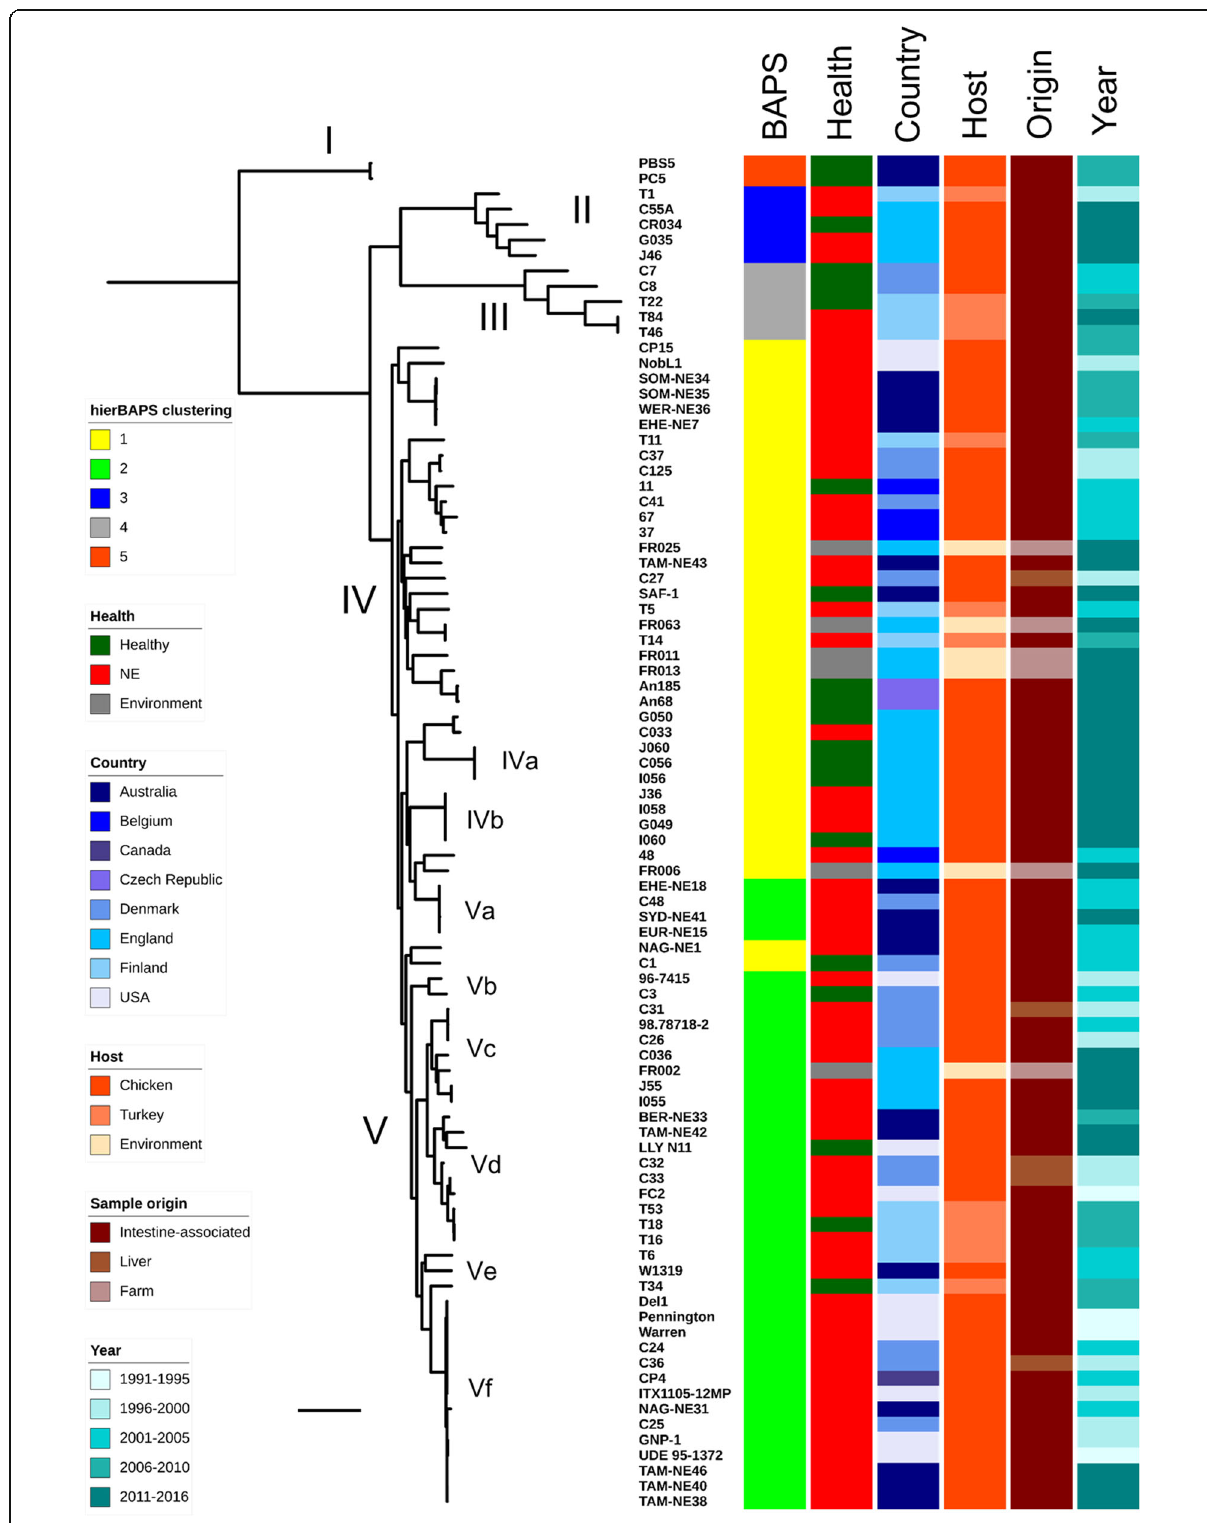
Fig. 1 Mid-point rooted maximum-likelihood tree based on 20,194 SNPs in 1810 core genes labelled by hierarchical Bayesian clusters (1 – 5), health states of hosts, country of isolates, poultry host species, sample origin and year of isolation. Scale bar, ~ 2000